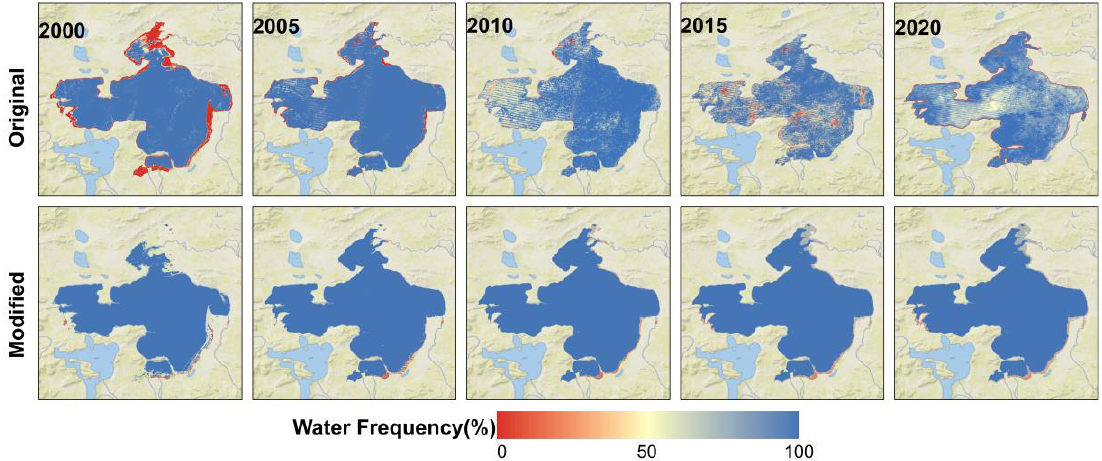
Figure 5. Results of the reconstruction of the water frequency data.